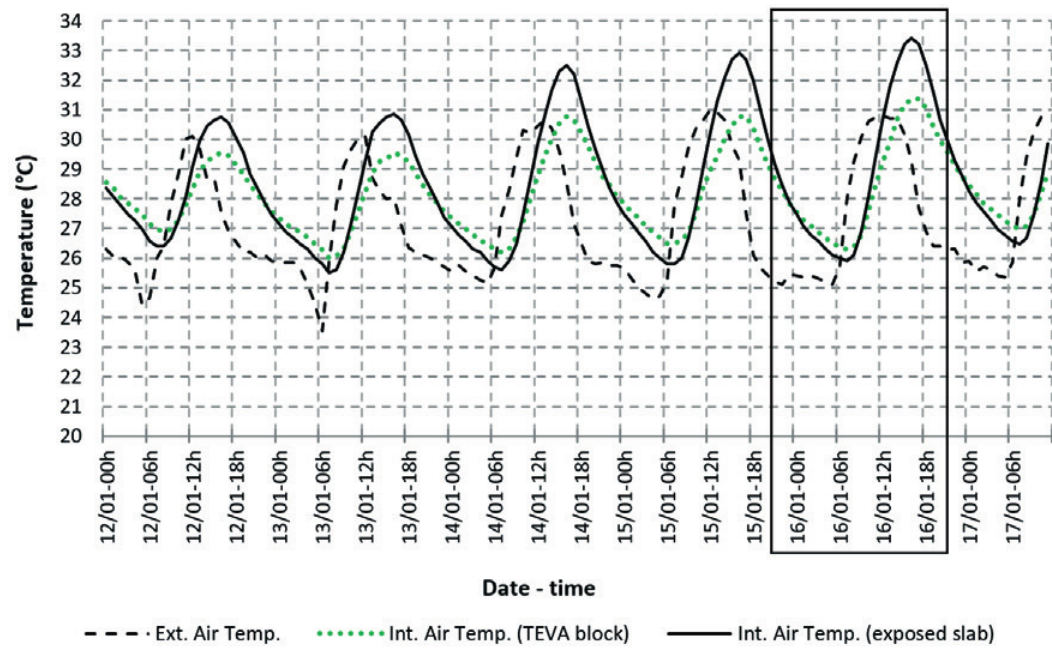
Records for the prototypes with exposed slab and with green roof with TEVA